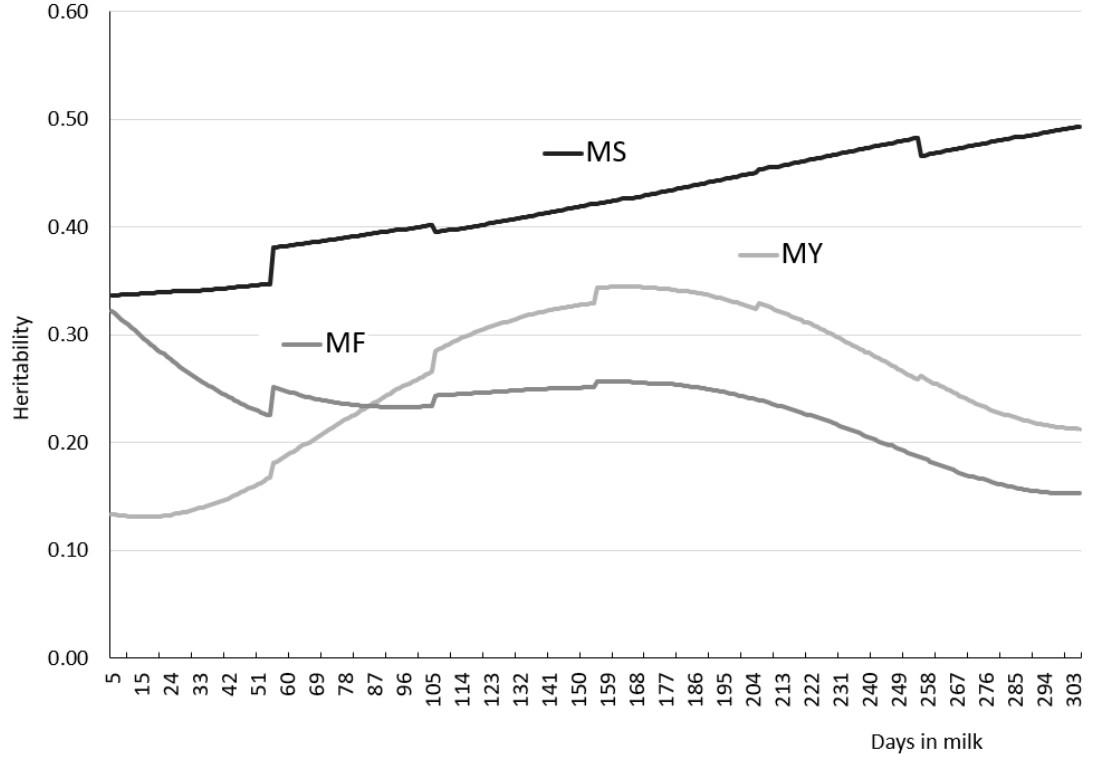
Figure 3. Heritabilities of milk yield (MY), milking frequency (MF) and speed (MS) in subsequent days in milk.